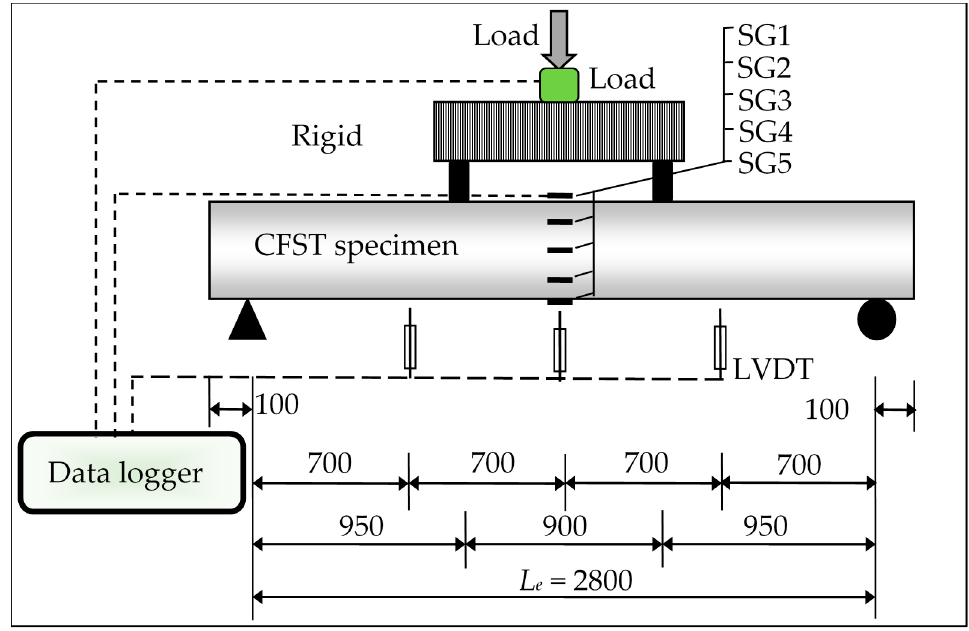
Figure 2. Schematic of specimens’ test setup (all dimensions in